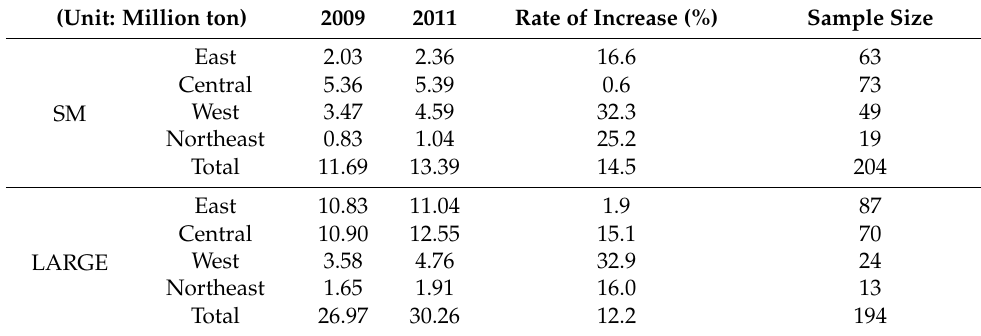
Table 4. Change in CRP for each production-scale and regional group.